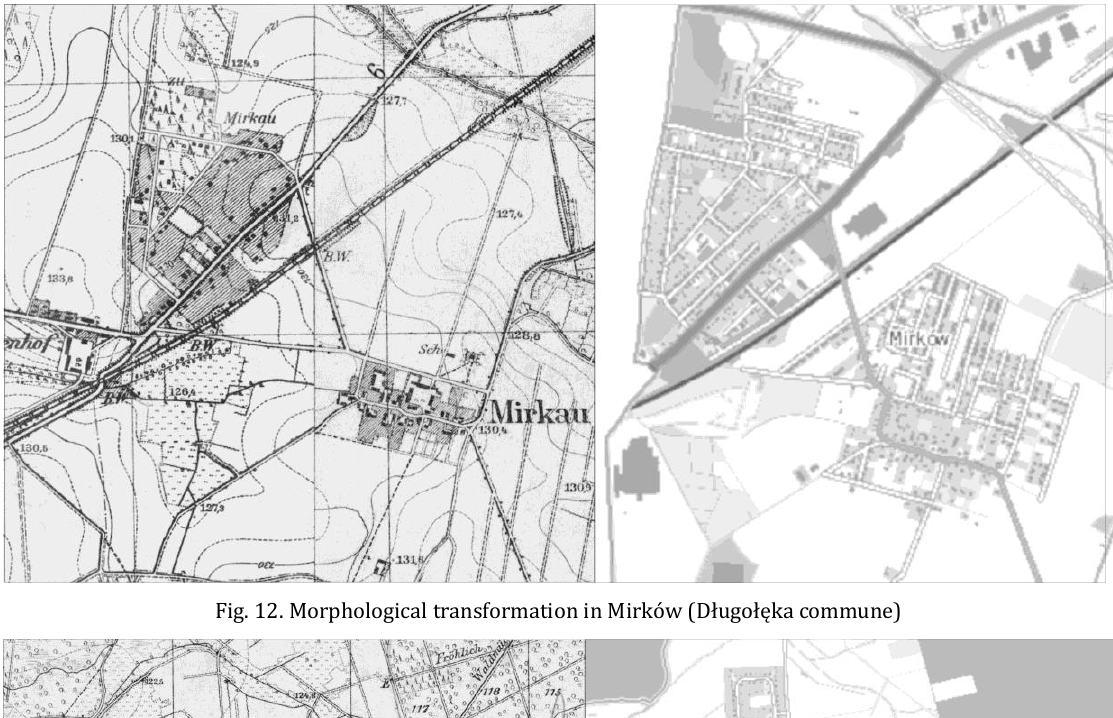
Fig. 12. Morphological transformation in Mirków (Długołęka commune)